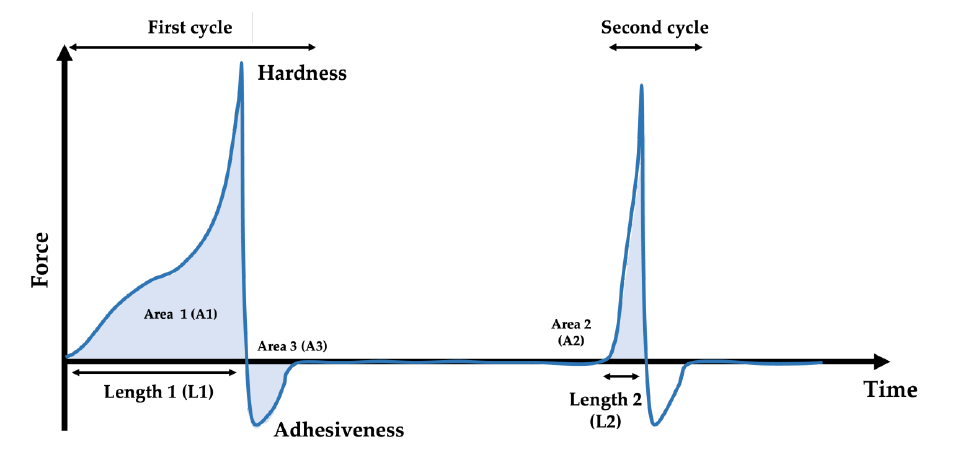
Figure 2. A typical force – time curve.